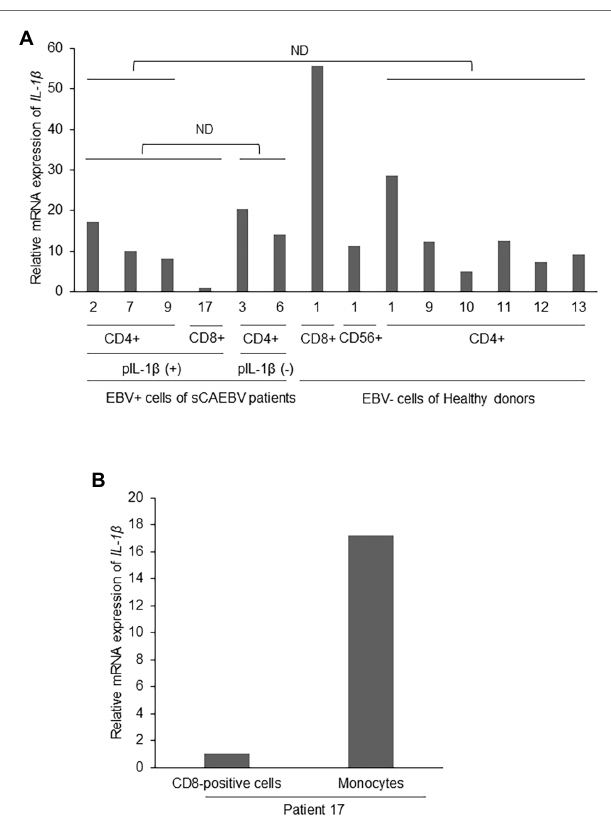
FIGURE 3 | Interleukin-1 β mRNA expression in EBV-infected cells of sCAEBV patients. (A) EBV-infected cells were collected from patients 2 (CD4), 3 (CD4), 6 (CD4), 7 (CD4), 9 (CD4), and 17 (CD8). Patient 2, 7, 9, and 17 had IL-1 β in their plasma while patient 3 and 6 had no plasma IL-1 β . CD4-positive cells were collected from six healthy donors and CD8- and CD56-positive cells were from the same healthy donor. The mRNA expression of IL-1 β in EBV-infected cells was analyzed by qRT-PCR assay. The expression was normalized to GAPDH mRNA. The value of vertical axis showed the expression in CD8-positive cells of patient 17 as 1. There were no significant differences between IL-1 β mRNA expression in the EBV-positive cells of patients with high plasma IL-1 β and patients with undetectable level of plasma IL-1 β . The mRNA expression of IL-1 β in the EBV-positive cells of sCAEBV patients was not higher than that of the same lymphocyte fractions of healthy donors. The statistical comparison was performed for mRNA of CD4-positive cells. (B) CD8-positive cells and monocytes derived from patient 17, who had plasma IL-1 β . The mRNA expression of IL-1 β in EBV-infected cells was analyzed by qRT-PCR assay. The expression was normalized to GAPDH mRNA. The value of vertical axis showed the expression in CD8-positive cells of patient 17 as 1. ND: no significant difference. pIL-1 β : plasma IL-1 β .